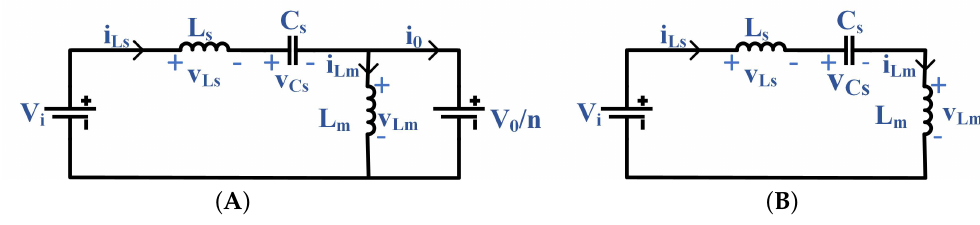
Figure 3. Equivalent circuits in PO mode, ( A ) energy transfer period in P mode, ( B ) freewheeling period in O